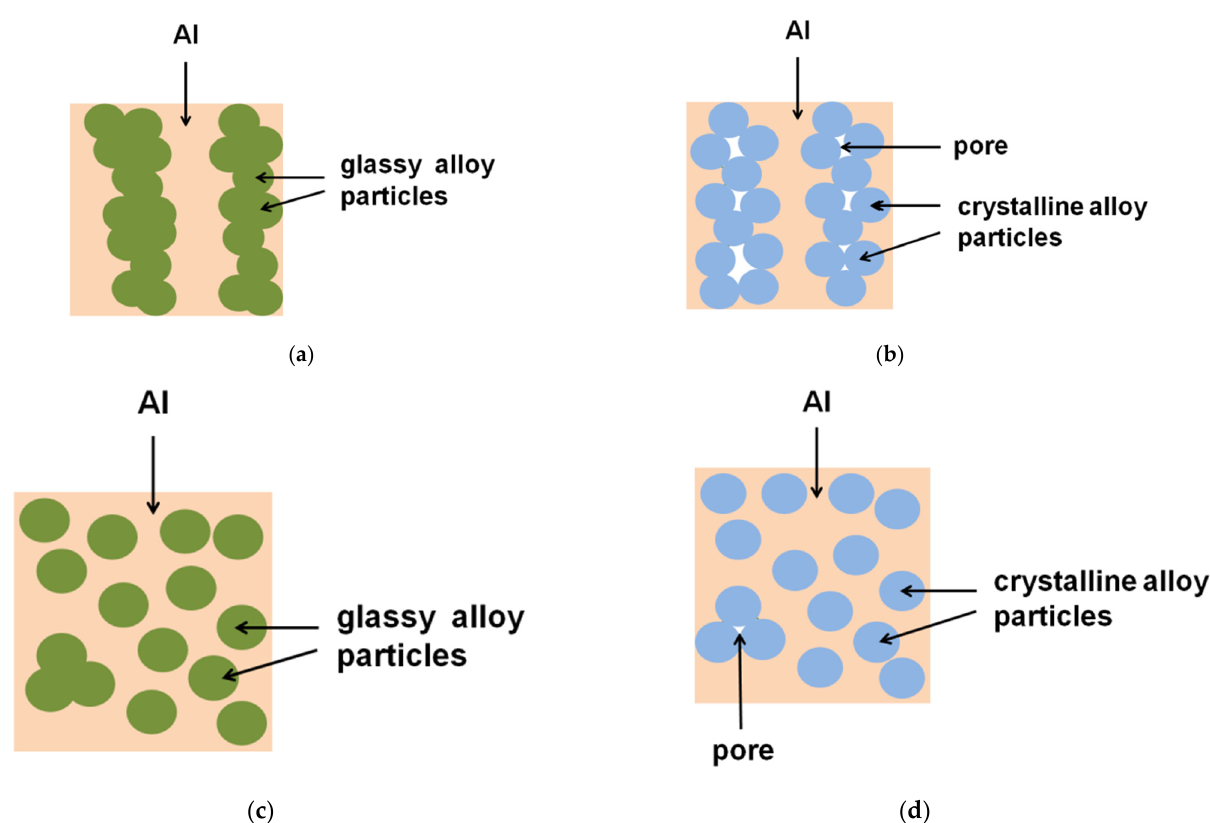
Figure 11. Schematic of the microstructures of aluminum matrix composites formed using a glassy ( a , c ) or a crystalline ( b , d ) alloy reinforcement. Reprinted from [82]. This article is an open access article distributed under the terms and conditions of the Creative Commons Attribution (CC BY) license (https://creativecommons.org/licenses/by/4.0/).